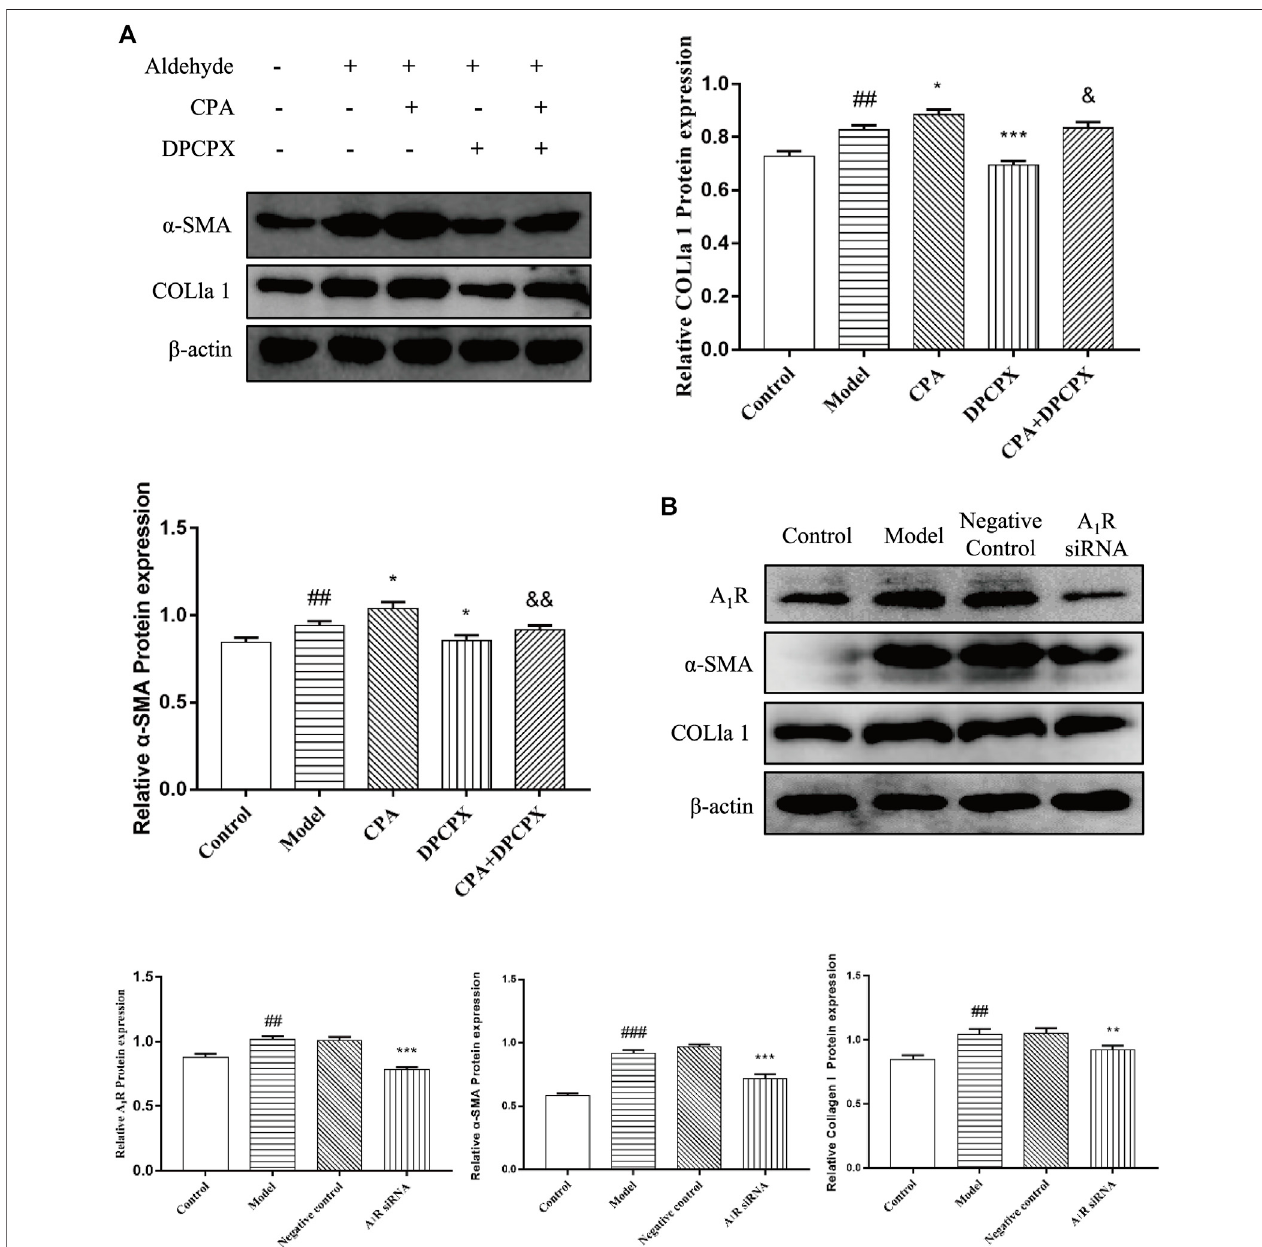
FIGURE 6 | Effect of silencing A 1 R on cell activation in acetaldehyde-induced HSC-T6 cell. (A) The protein levels of α -SMA and COL1a1 in HSC-T6 cell. ## p < 0.01 vs. the control group. *p < 0.05, ***p < 0.001 vs. the model group. & p < 0.05, && p < 0.01 vs. the CPA group. (B) The protein levels of A 1 R, α -SMA, and COL1a1 in HSC-T6 cell. ## p < 0.01, ### p < 0.001 vs. the control group. **p < 0.01, ***p < 0.001 vs. the negative control